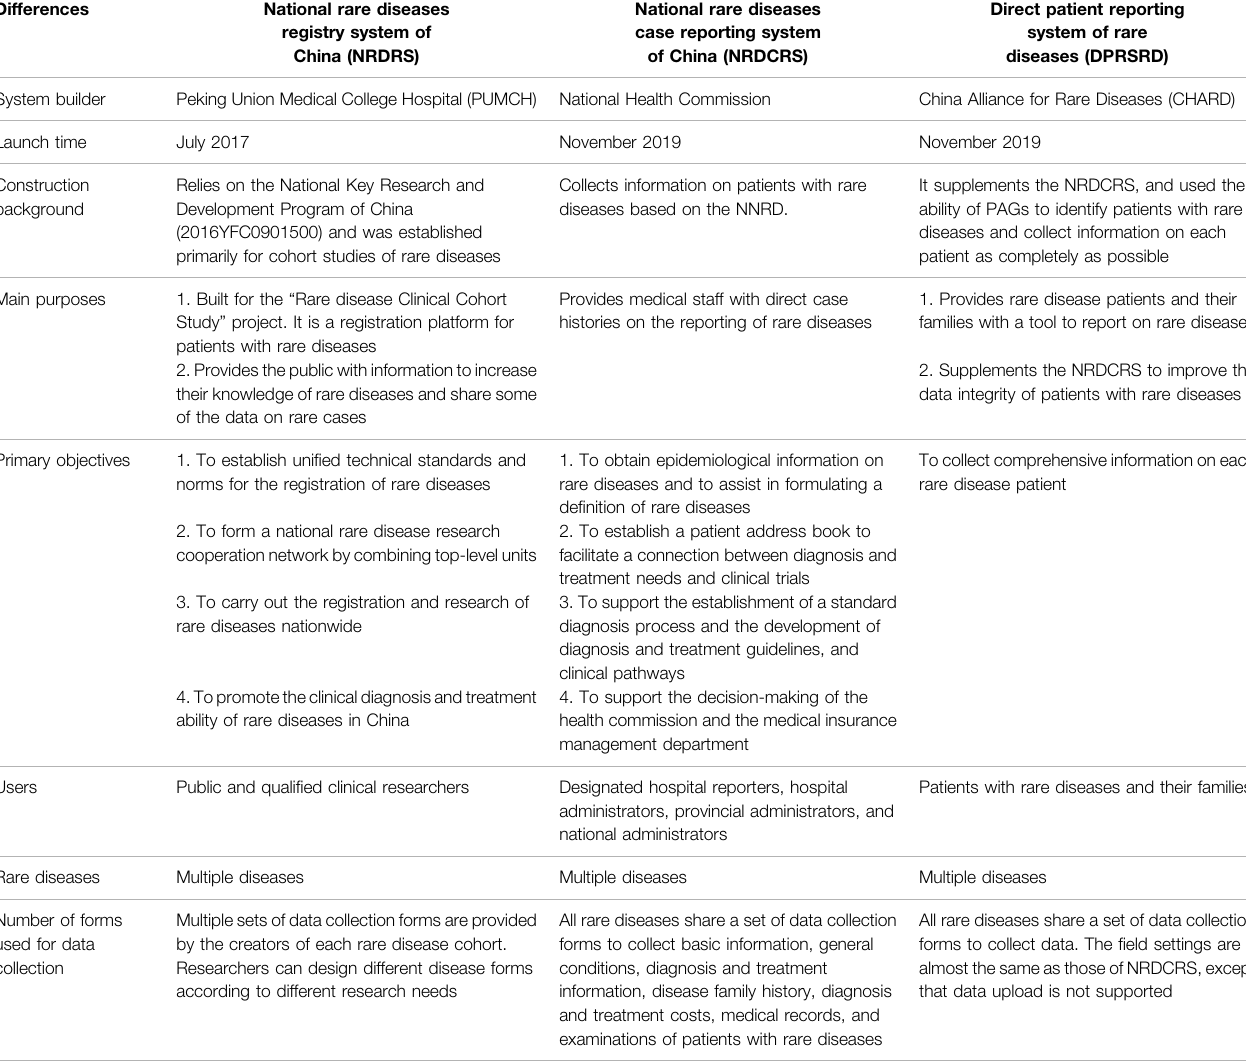
TABLE 2 | The differences between NRDRS, NRDCRS and DPRSRD